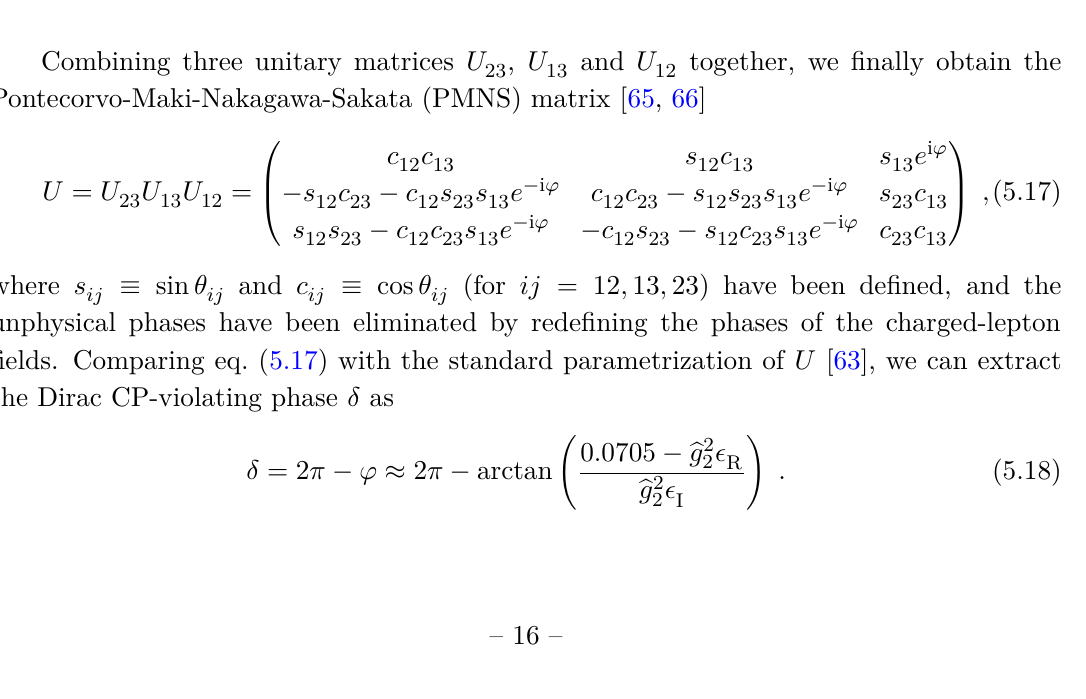
Figure 3 . The distributions of { sin 2 δ, sin 2 ρ, sin 2 σ } in the vicinity of τ = i , where = − 0 . 350 are fixed. The vertical dotted line corresponds to Re τ = − 0 . 0343 , which is the typical g e 3 value of Re τ in its 3 σ allowed parameter